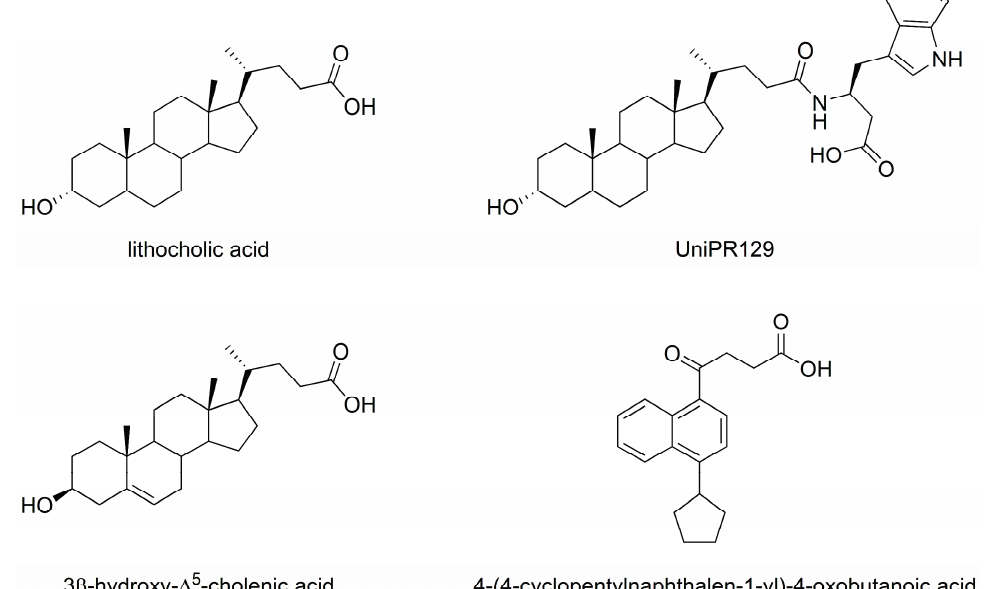
Figure 1. Chemical structures of selected EphA2 receptor